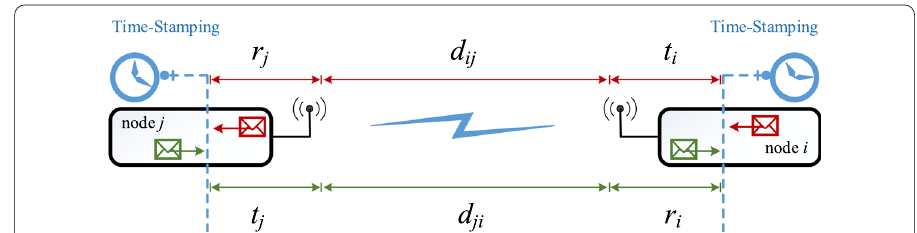
Fig. 1 Decomposition of delay into its constituent components